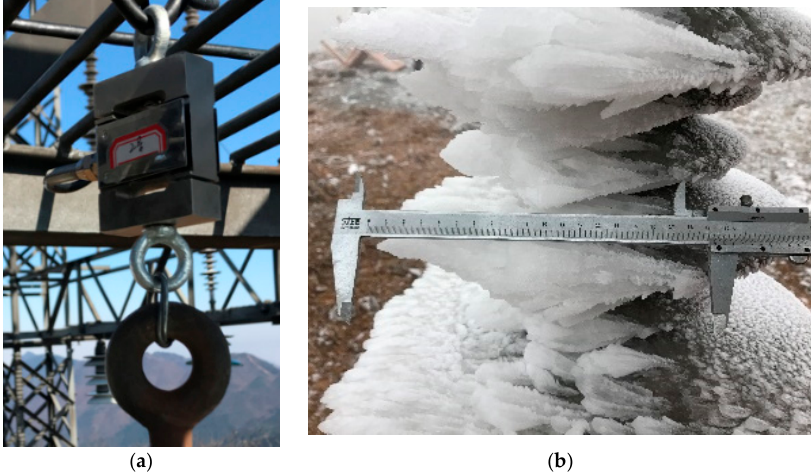
Figure 10. ( a ) Tension sensor ( M = 40 kg) connected to the insulator ( b ) surveying horizontal ice thickness.